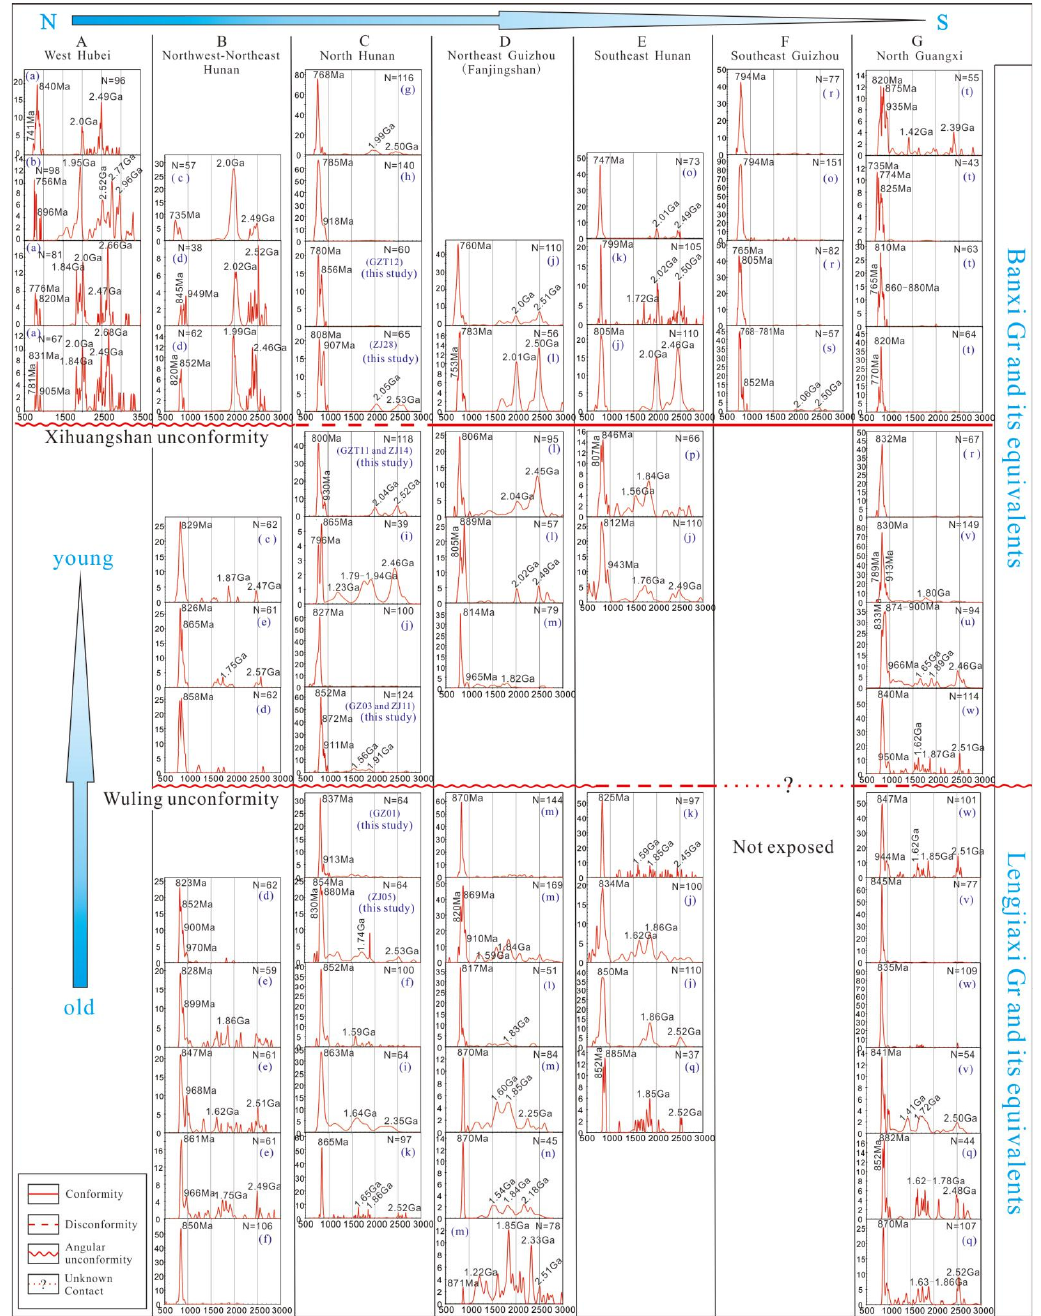
Figure 10. U − Pb age histograms of the detrital zircons from Banxi and Lengjiaxi groups and their equivalents in the west Hubei ( A ), northwest–northeast Hunan ( B ), north Hunan ( C ), northeast Guizhou ( D ), southeast Hunan ( E ), southeast Guizhou ( F ) and north Guangxi ( G ) from the Yangtze Block. Lowercase letters in parentheses represent data sources: ( a ) Liu et al. [73]; ( b ) Zhang et al. [122]; ( c ) Yan et al. [72]; ( d ) Wang et al. [75]; ( e ) Wang et al. [69]; ( f ) Zhang et al. [36]; ( g ) Liu et al. [123]; ( h ) Song et al. [55]; ( i ) Zhang et al. [97]; ( j ) Su et al. [96]; ( k ) Meng et al. [68]; ( l ) Wang et al. [74]; ( m ) Zhang et al. [43]; ( n ) Zhou et al. [95]; ( o ) Wang et al. [76]; ( p ) Wang et al. [70]; ( q ) Wang et al. [23]; ( r ) Qin et al. [52]; ( s ) Wei et al. [124]; ( t ) Wang and Zhou, [44]; ( u ) Wang et al. [71]; ( v ) Ma et al. [39]; ( w ) Yang et al. [18]; and this study. 207 Pb/ 206 Pb ages are used for zircons with ages >1000 Ma, 206 Pb/ 238 U ages are used for zircons younger than 1000